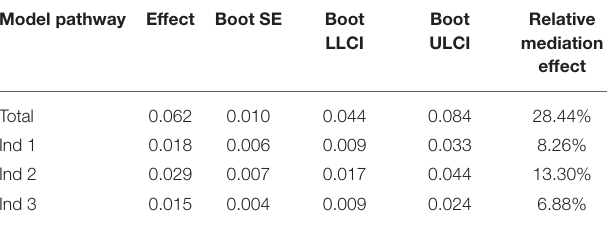
TABLE 2 | Standardized indirect effects and 95% confidence